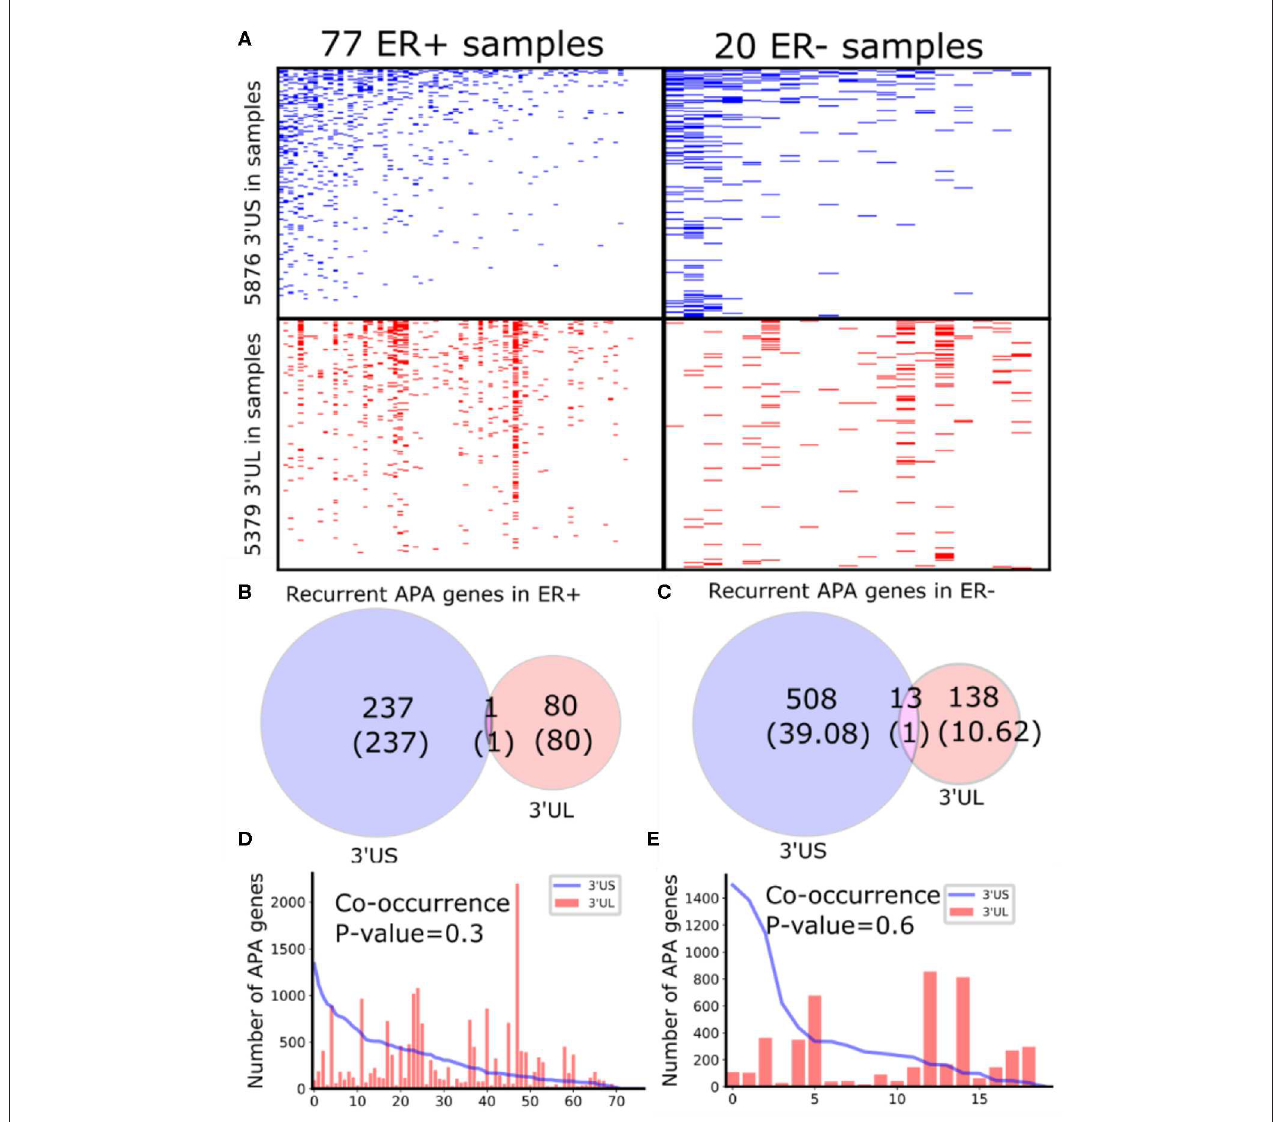
FIGURE 1 | Global APA events distinct for ER or ER- samples (right column), ranked by the total number of APA events. (B,C) Overlap of the recurring ( > 20% in samples) 3 ′ US and 3 ′ UL genes in ER respectively. (D,E) The number of APA genes (3 ′ US in line and 3 ′ UL in red bar) in the tumor–normal sample pairs in ER